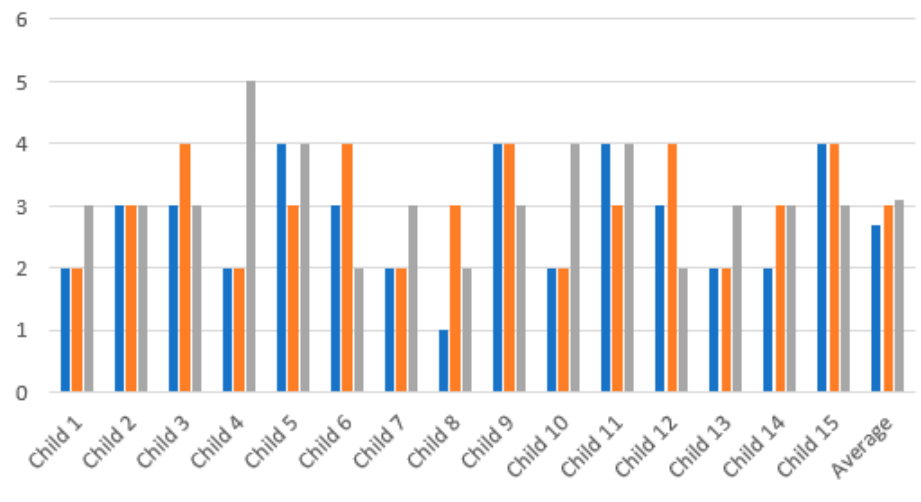
Figure 10. Autistic children’s interaction with the three face collections on the second day. Table 8. The caregiver reports on child interaction with the facial expression of the three face collections with correct answers (0–20) for ASD children in the two days.